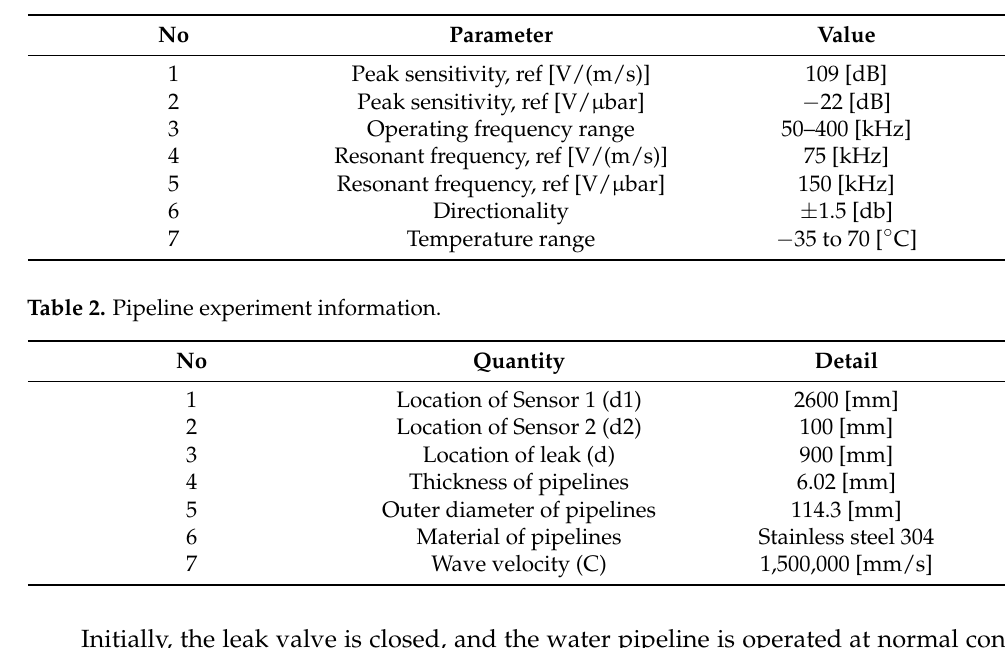
Figure 9. MED method for the acoustic signals in Channel 1. Figure 10. MED method for the acoustic signals in Channel 2. As with acoustic signals such as those in Channel 1 and Channel 2, MED can use the maximization kurtosis norm to remove noise from the mixed signals. After MED pro- cessing, the feature impulse signals were detected for easy damping frequency energy processing. To validate leak localization in the pipelines, Figures 11 and 12 show the first arrival times for Channel 1 and Channel 2. Combined with the velocity to localize the leak, the result is 859 mm, and the relative error is 1.64%. To validate the performance of the proposed method compared with those of the GCC and EMD + GCC methods, the correct leak localization for the GCC method was 1086 mm, and the relative error was 7.44%. For the EMD + GCC method, the leak localization result was 1027 mm, and the relative error was 5.08%. These findings demonstrate better leak localization with the proposed method than with the others.